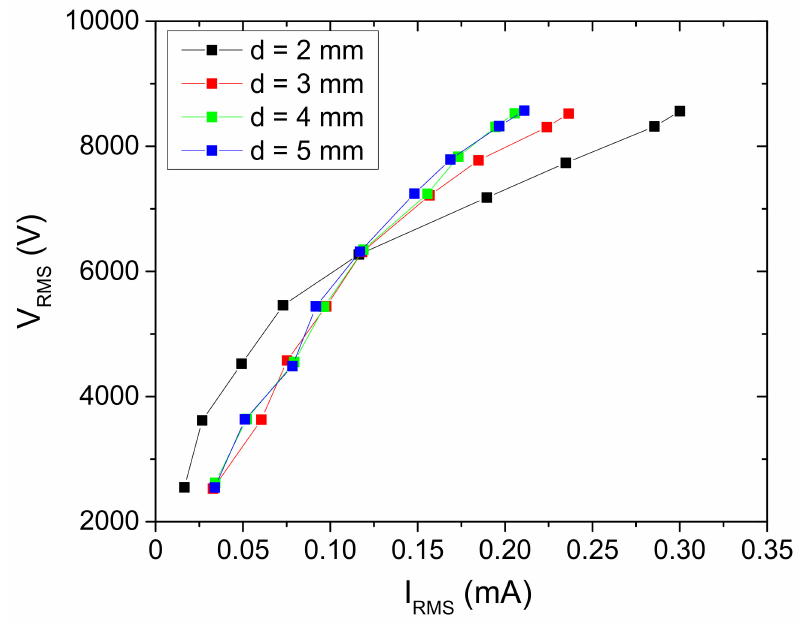
Figure 8. Volt–ampere characteristics of the SDBD obtained for the different distances between the powered electrode and the sample. The discharge was operating in air.